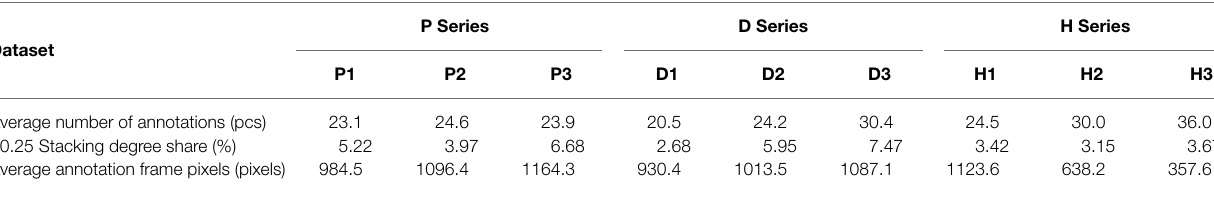
TABLE 4 | Statistical table of dataset indicators.